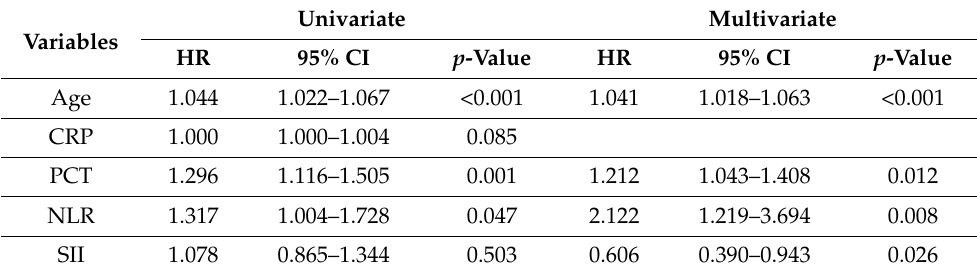
Table 6. Univariate and multivariate Cox model